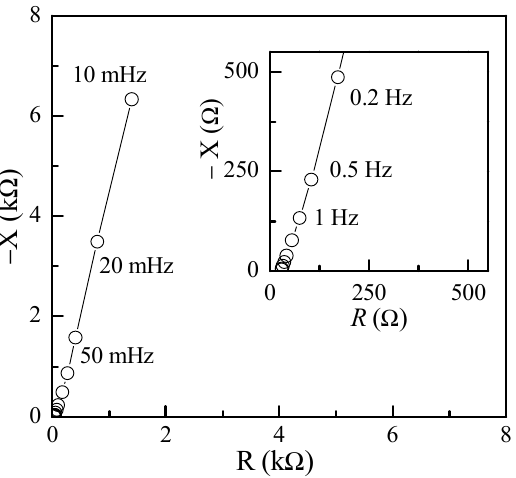
Figure 14. Imaginary vs. real component of the impedance on a typical Au/PPy- GNP:DBSA/Nafion:LiPs/PPy-GNP:DBSA/Au cell at frequencies between 10 mHz and 100 Hz.